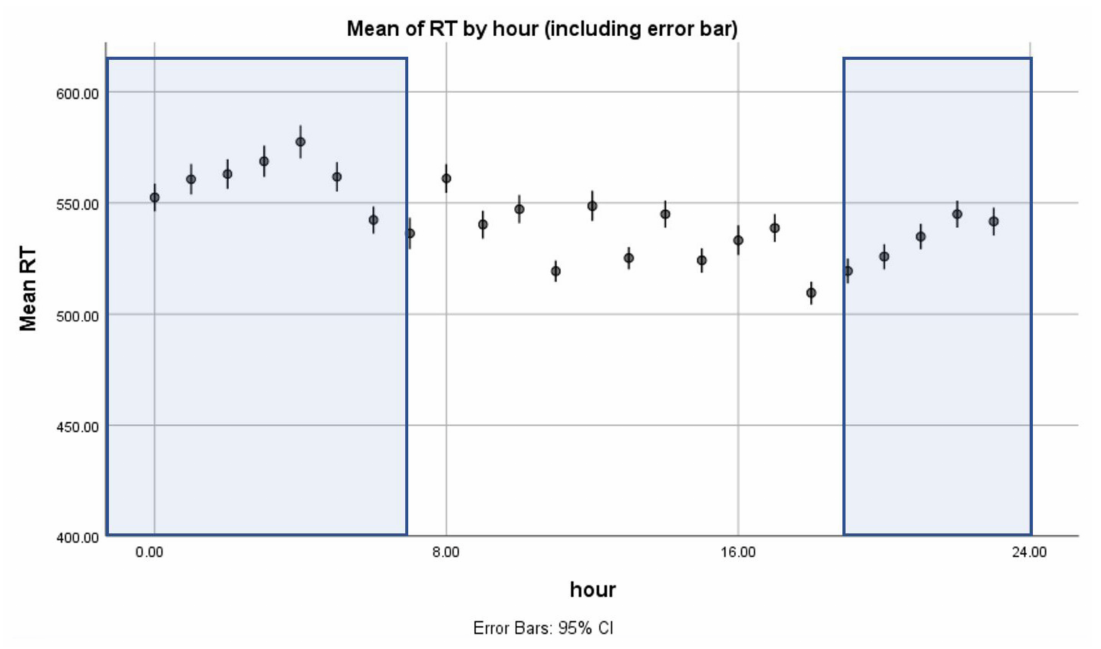
Figure 5. Aggregated RT across the hours of the day, including 95% error bars (Highlighted area shows night shift, the rest is for day shift).